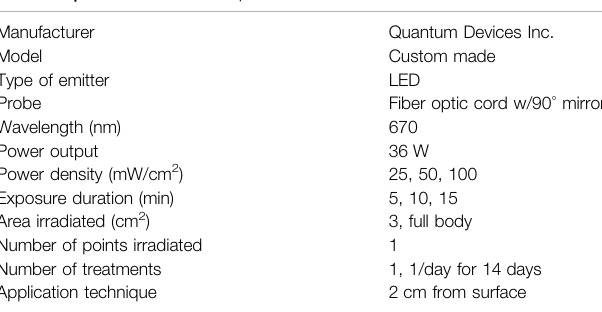
TABLE 1 | Photobiomodulation parameters. Manufacturer Quantum Devices Inc.